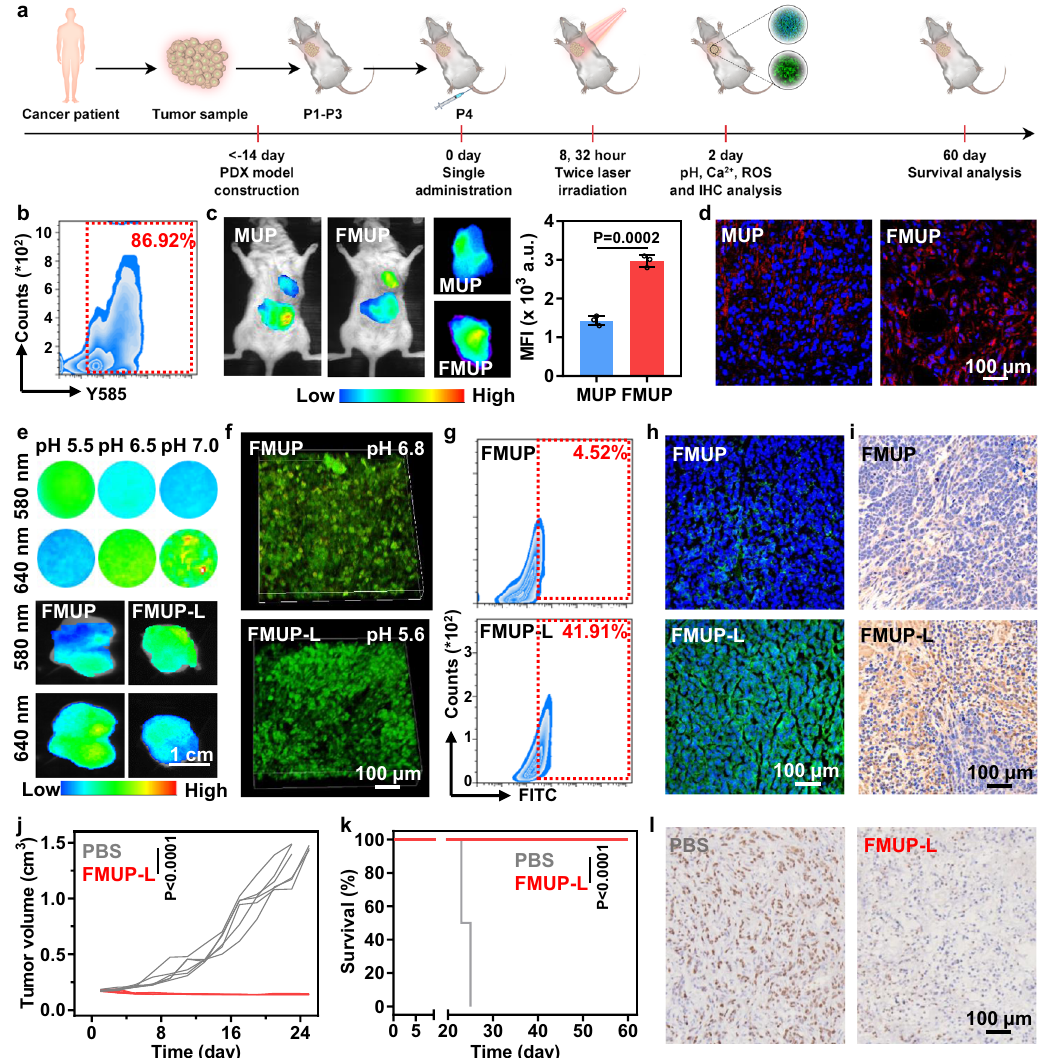
Fig. 8 In vivo antitumor effects in patient-derived tumor xenograft (PDX) model. a Schematic illustration of procedure for evaluating antitumor activity in liver-cancer-PDX model. Note that mice in the groups with the involvement of light irradiation underwent treatment of irradiation (980 nm, 1.0 W/cm 2 , 5 min) twice, at 8 h and 32 h, respectively, after a single intravenous administration. b The analysis of the expression of folate receptor in human hepatoma cells sourced from PDX tumor by using fl ow cytometry. c In vivo fl uorescence imaging of biodistribution of MUP and FMUP in tumor-bearing mice 8 h after injection and the corresponding quantitative analysis for various tumors. The color gradient represents the range from the minimum mean fl uorescence intensity (1400) to the maximum fl uorescence intensity (4200). d Frozen section staining images of tumors in the group of MUP and FMUP. Red: Cy 5-lablled MOFs; Blue: nuclei. e Fluorescence imaging of tumor pH in the group of MUP and FMUP using SNARF ® -1. The color gradient represents the range from the minimum mean fl uorescence intensity (560) to the maximum fl uorescence intensity (1830). f Two-photon fl uorescence imaging of tumor pH in the group of FMUP and FMUP-L using SNARF ® -1. g The quantitative analysis of ROS in tumors in the group of FMUP and FMUP-L via fl ow cytometry using DCFH-DA as the probe. h Frozen section staining imaging of tumors for evaluating the calcium in fl ux after different treatments using Fluo-3 as the probe. i Immunohistochemical staining images and further quantitative analysis of UCP 2 in tumor tissue for indicating the mitochondrial damage. j Tumor growth curves of different treatments over 25 days. k Survival curves of tumor-bearing mice in the group of PBS and FMUP-L. l Representative cell proliferation analysis of tumor tissue by Ki 67 method. Data in ( c ), ( j ), and ( k ) were represented as mean values± SD, n = 3 biologically independent samples in ( c ), n = 6 biologically independent samples in ( j , k ). A representative image of three biologically independent samples from each group is shown in ( b – i , l ). P value was calculated by the two-tailed Student ’ s t test in ( c , j ). P value was calculated by the Log-rank test in ( k with Cu 2 + in constructing the MOF shells is expected to enable Cu + -mediated pyroptosis pathway and chemodynamic therapy based on the photocatalyzed reduction of Cu 2 + to highly active Cu + for Fenton-like reaction. Additionally, integrating drug active ingredients into the organic linkers could be a way for introducing additional antitumor activity for further enhance- ment of therapeutic effects.